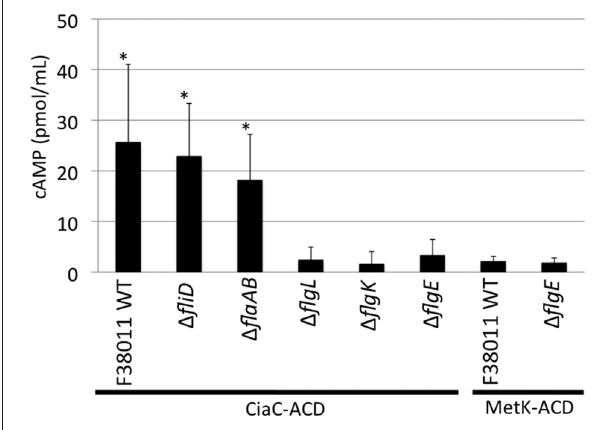
FIGURE 3 | The CiaC virulence proteins is delivered to the cytosol of INT 407 cells from the C. jejuni F38011 wild-type strain, fliD mutant, and flaAflaB mutant, but not flgL, flgK, and flgE mutants. Delivery of the CiaC-ACD fusion protein from the cytosol of C. jejuni to the cytosol of INT 407 cells was assayed in the C. jejuni F38011 wild-type strain and isogenic fliD, flaAflaB, flgL, flgK, and flgE mutants, and delivery of MetK-ACD was assayed in the C. jejuni F38011 wild-type strain and flgE mutant. The concentration of cAMP within the INT 407 cells was assayed 30min post-infection. The error bars represent one standard deviation from mean. The asterisk indicates values that are significantly different from the flgE mutant harboring ciaC-ACD as judged by the Student’s t -test ( P < 0 . 05). Data from two biological replicates were combined.